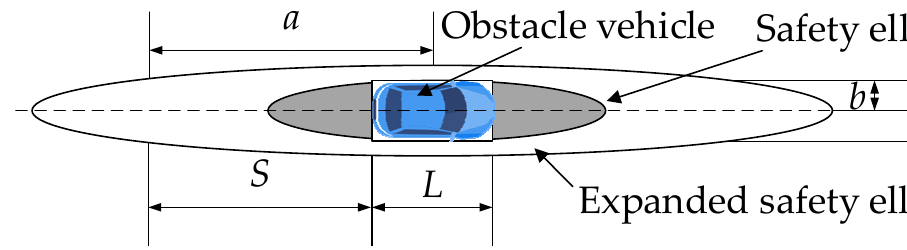
Figure 5. The obstacle vehicle